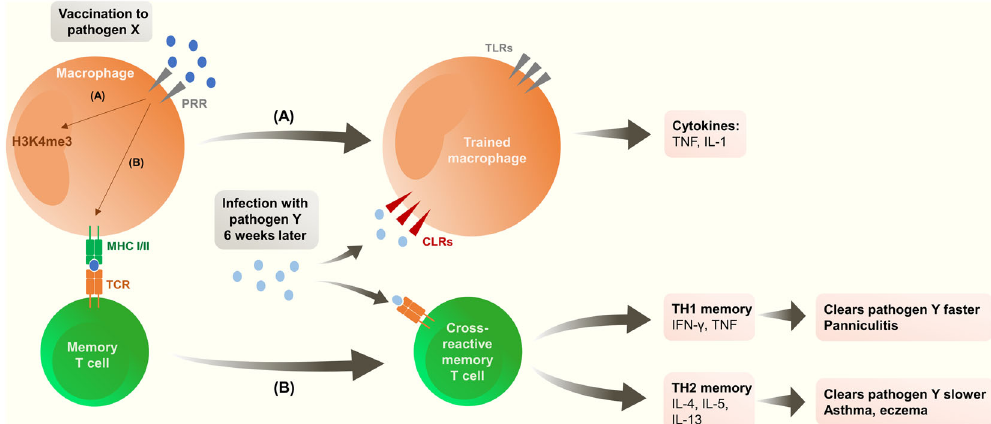
Fig. 3 Possible immunological mechanisms explaining downstream effects of vaccination (adapted from Benn 2013). After vaccination for pathogen X two possible pathways may explain downstream effects: A Epigenetic re-programming of monocytes/macrophages leading to a more rapid activation after exposure to pathogen Y, to ensure rapid clearance of this pathogen. B T cell-mediated cross-reactivity: memory CD4 and CD8 T cells are generated that are cross-reactive with pathogen Y. PRR pattern recognition receptors, MHC major histocompatibility complex, TLR Toll-like receptors, CLR C-type lectin receptors, TCR T cell